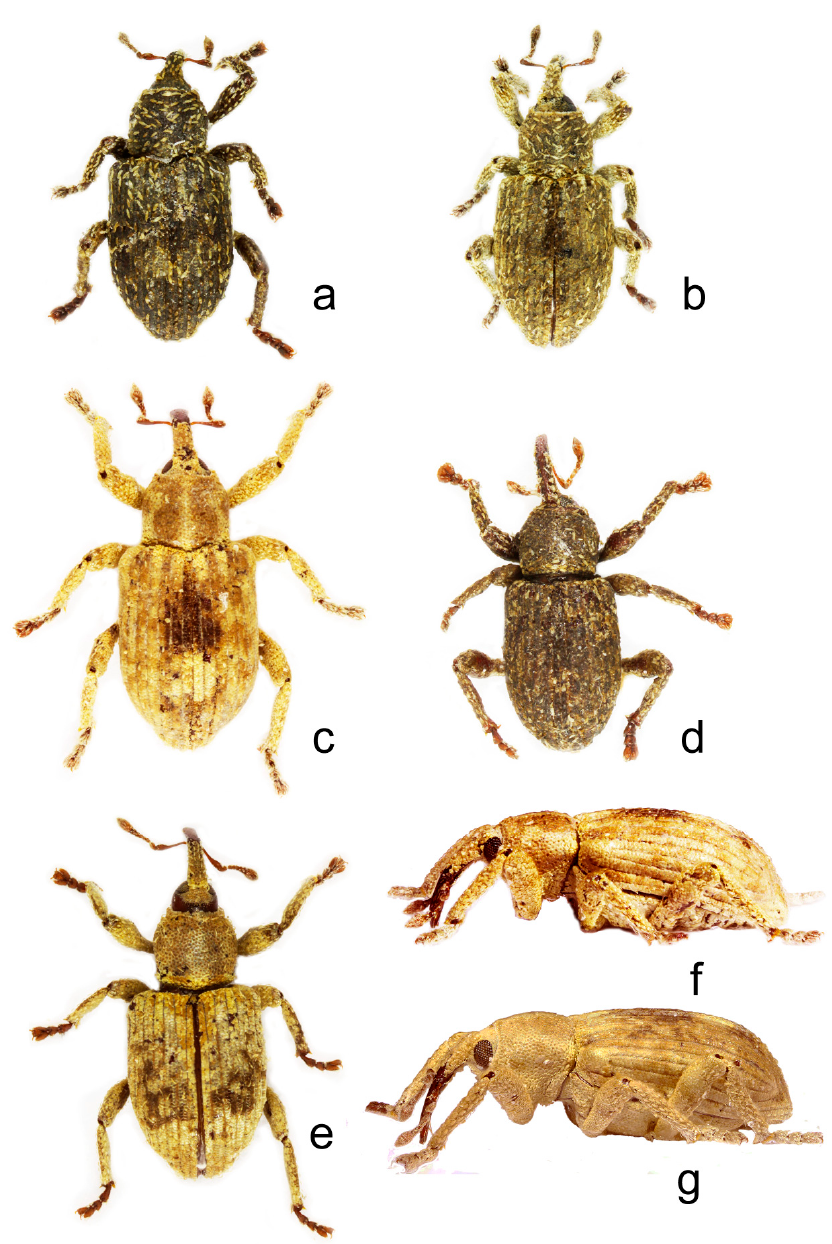
Figure 1. Habitus of ( a ) Afroryzophilus djibai ♂ ; ( b ) A. centrafricanus ♂ ; ( c ) A. kuscheli ♂ ; ( d ) A. congoanus ♂ ; ( e ) A. somalicus ♀ ; ( f ) A. kuscheli ♂ in lateral view; ( g ) A. kuscheli ♀ in lateral view. (Not